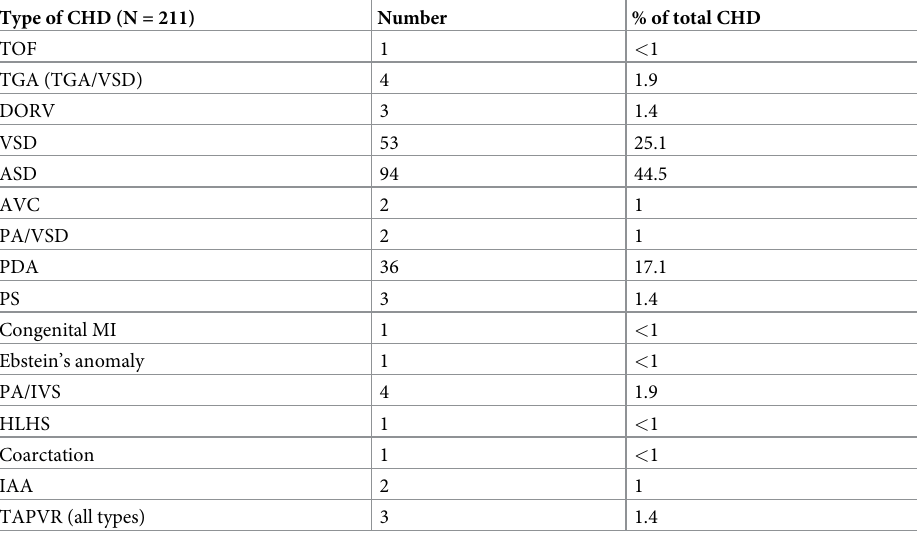
Table 1. Distribution of CHD sub-types in the Da Nang region, 2015–2016. Type of CHD (N = 211) Number % of total CHD TOF 1 < 1 TGA (TGA/VSD) 4 1.9 DORV 1.4 VSD 53 25.1 ASD 94 44.5 AVC PA/VSD PDA 36 17.1 PS 3 1.4 Congenital MI 1 < 1 Ebstein’s anomaly 1 < 1 PA/IVS 4 1.9 HLHS 1 < 1 Coarctation 1 < 1 IAA 2 1 TAPVR (all types) 3